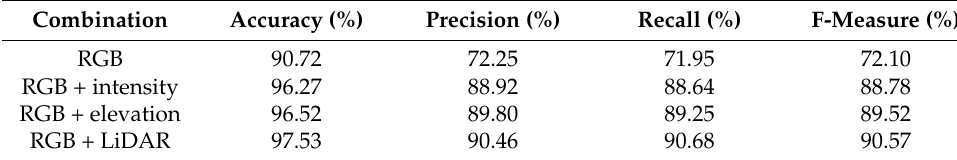
Figure 22. Training and validation curves of accuracy and loss for the RGB + LiDAR case. Table 3. Comparison of indicator parameters for the four combinations using